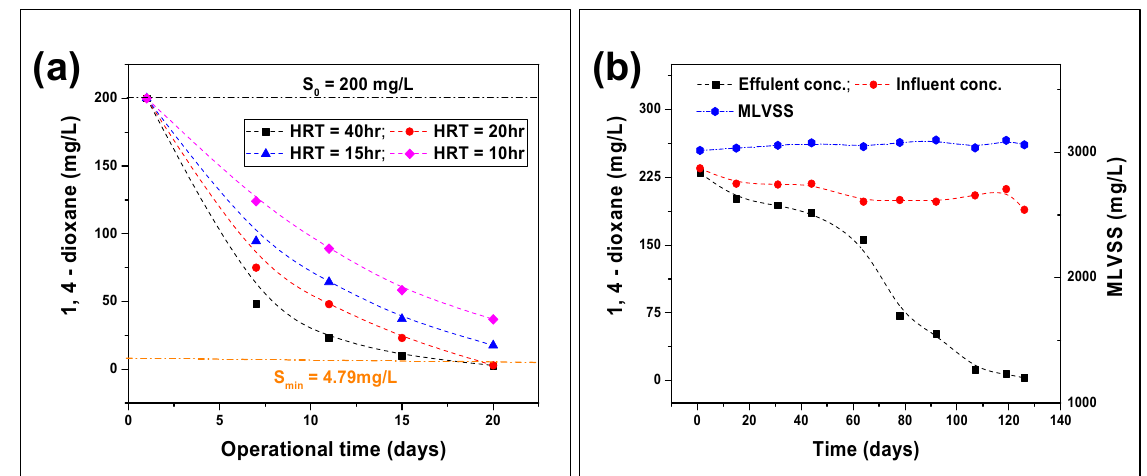
Figure 4. Lab-scale operation of the CSTR plant for 1,4-dioxane biodegradation under a mixed culture grown on the BSM and sludge mixture using 1,4-dioxane as a substrate source: ( a ) HRT optimization at a biomass concentration of 3000 mg/L; ( b ) 1,4-dioxane biodegradation from industrial wastewater under long-term operation with optimized conditions .